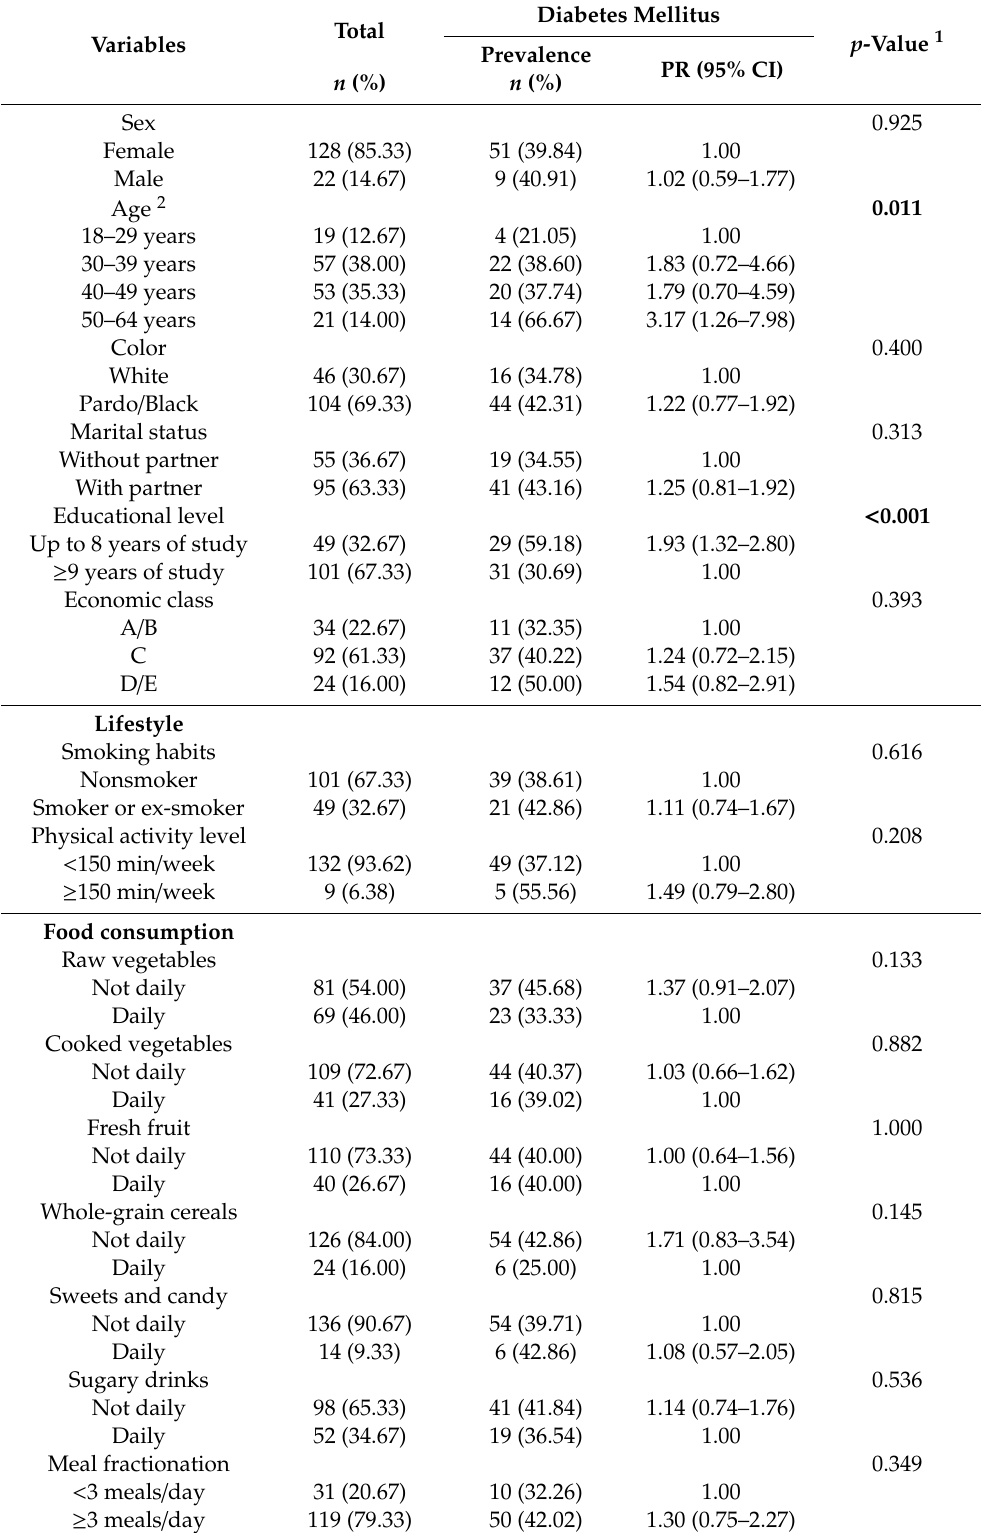
Table 1. Prevalence of type 2 diabetes mellitus and its associated factors in class II and III obesity with respect to sociodemographic, lifestyle, and food consumption